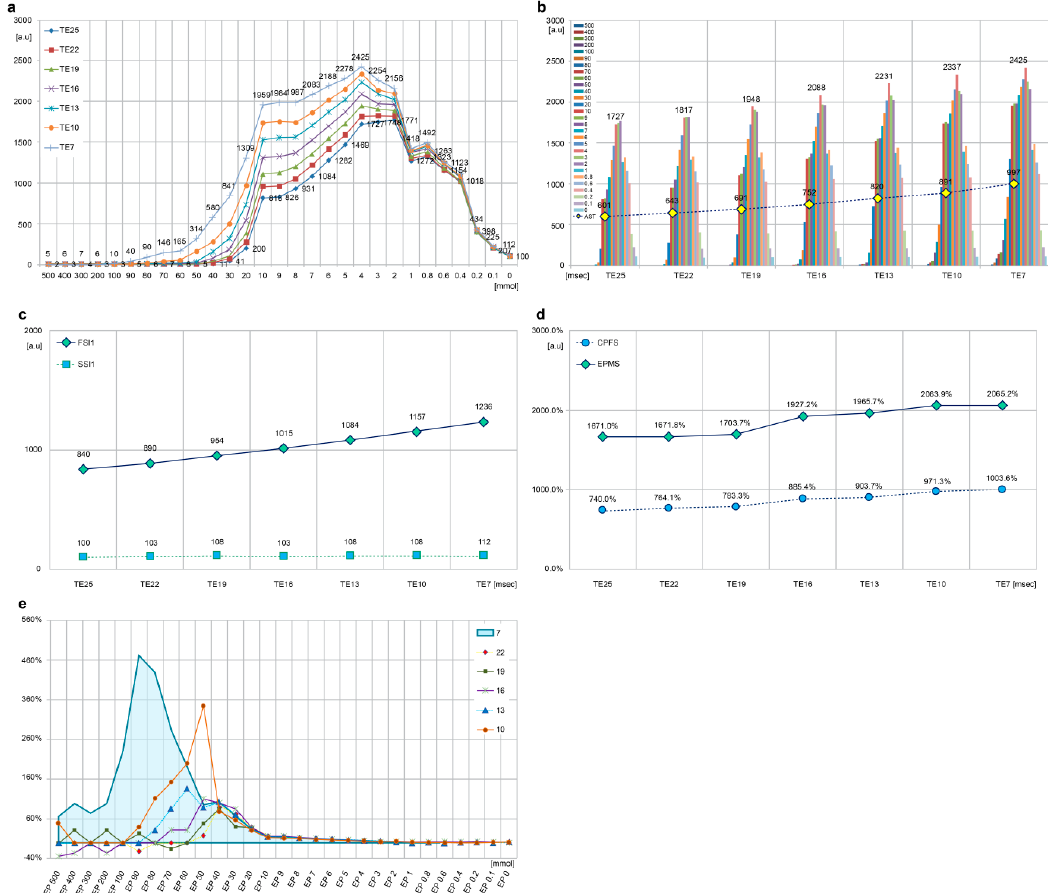
Figure 5. Graphs of signal changes according to various conditions. ( a ) Signal changes at each TE by concentration; ( b ) signal changes at each concentration and AST by TE; ( c ) saline and fat signal changes at each TE; ( d ) CPFS and EPMS signal changes at each TE; ( e ) EP changes at each concentration. TE, echo time; AST, average of SI for each mol per TE; CPFS, contrast percentage of fat to saline; EPMS, enhancement percentage of MPSI to saline; MPSI, max peak signal intensity; EP, enhancement percentage; SSI1, saline signal intensity of phantom study; FSI1, fat signal intensity of phantom study. Table 3. Quantitative data for the different evaluation criteria in the phantom study.